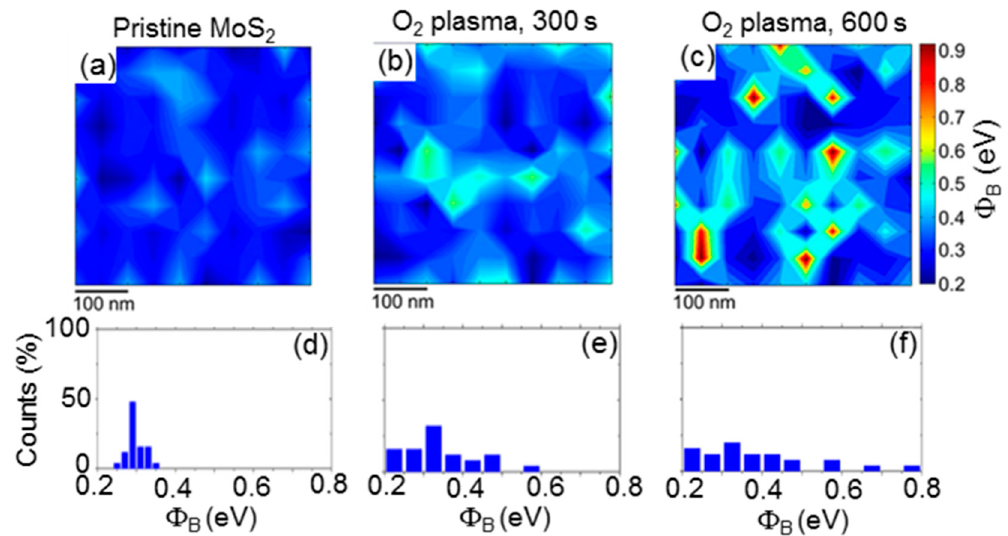
Figure 6. Schottky barrier height maps and histograms on pristine MoS 2 ( a , d ) and after O 2 plasma for 300 ( b , e ) and 600 s ( c , f ). Images adapted with permission from Reference [29], copyright from the American Chemical Society 2017.